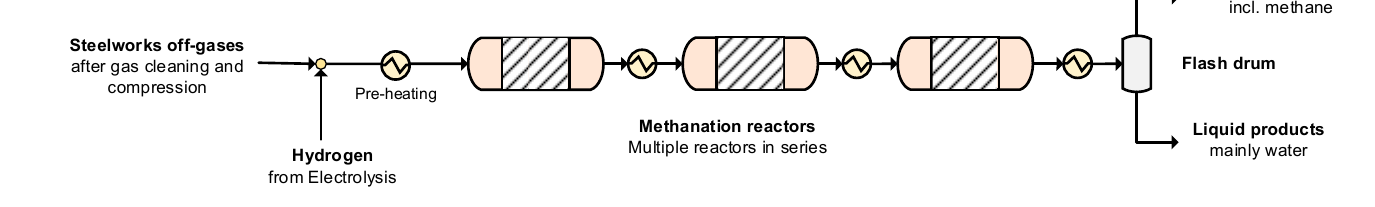
Figure 7. Methanation process flowsheet.